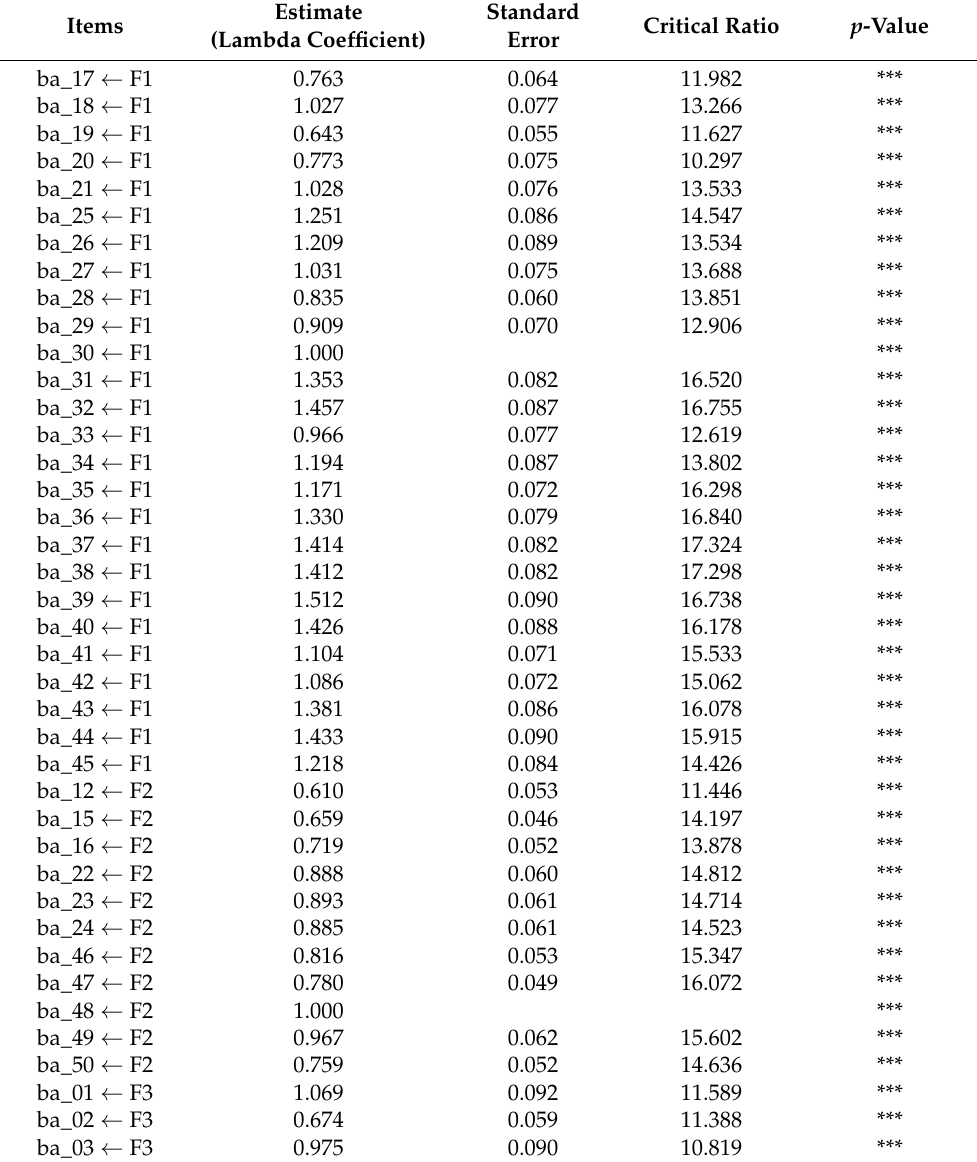
Table 6. Critical ratios and lambda coefficients of the items in the